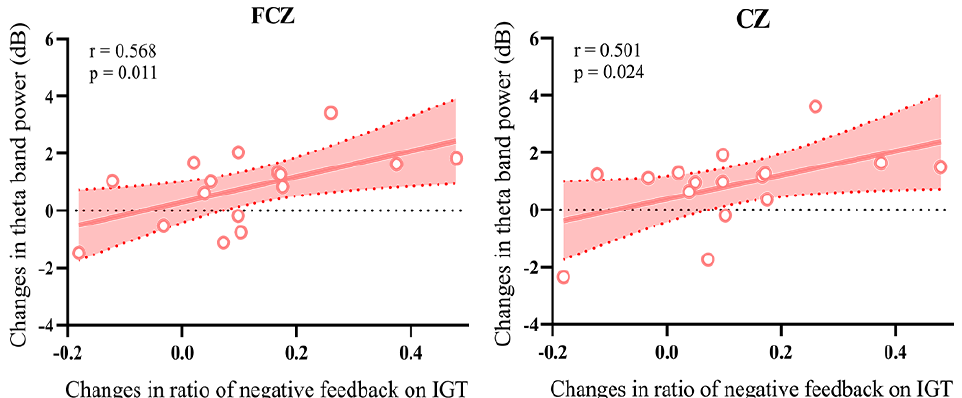
Figure 6. Correlation of changes between IGT performance and theta oscillation power. The increased power values of theta oscillation were significantly positively correlated with the changes in the percent use of negative feedback after HD-tDCS [The red shaded areas are the 95% confidence intervals. The circles represented the value of each participants in active group] .